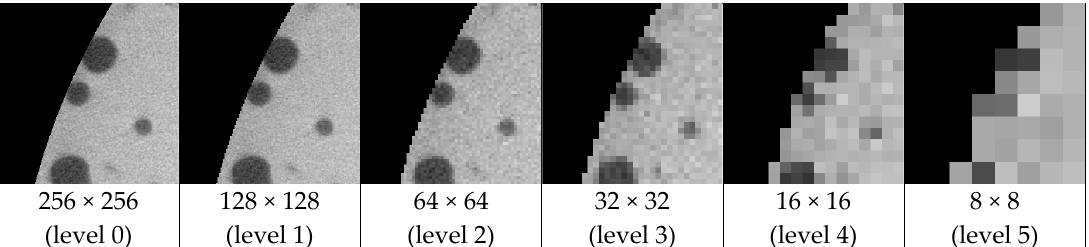
Figure 5. Pure downscaling of a patch. This figure illustrates the resolution at each level of U-Net.